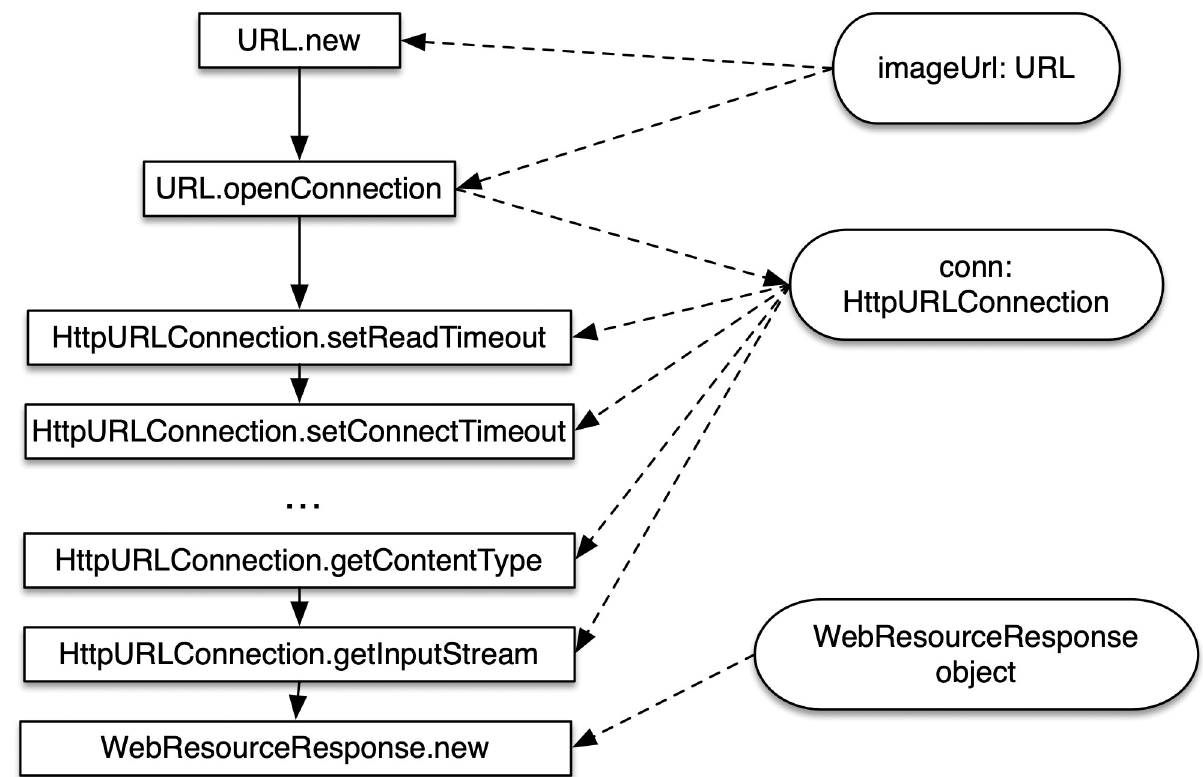
Fig 4. The extracted Groum of the added